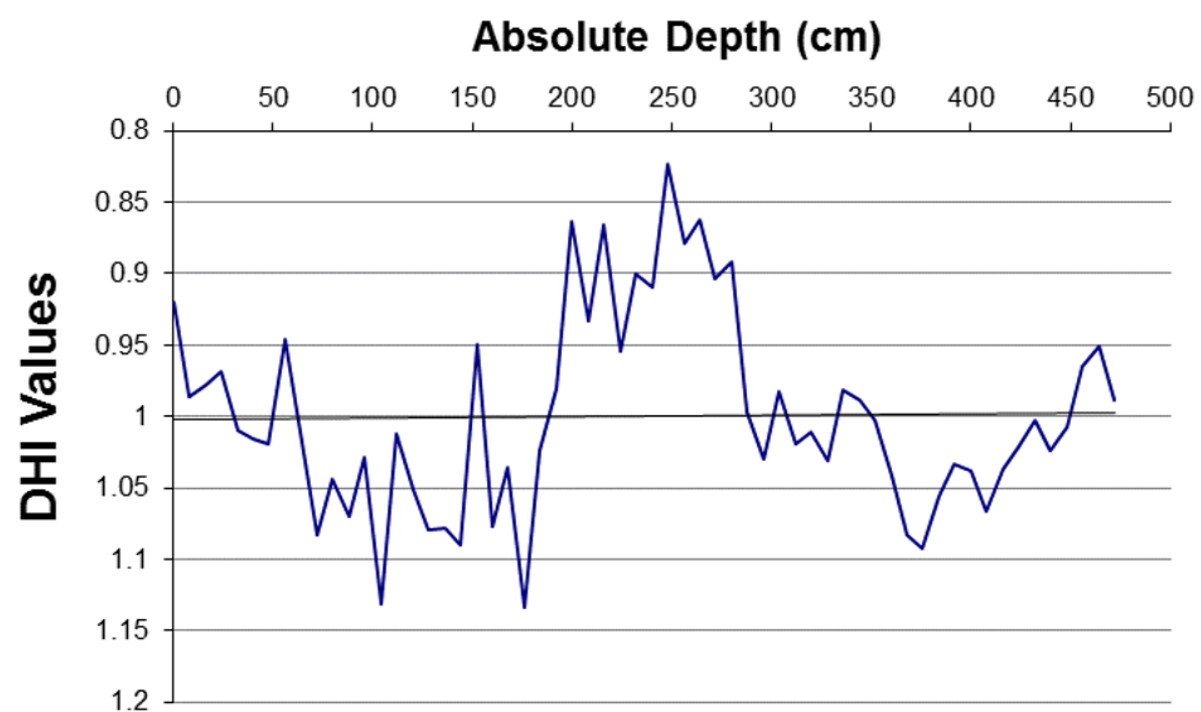
Figure 6. Smoothed and de-trended DHI curve for plant macrofossils. Indices used were: UOM 8, Ericales rootlets 8, Vaccinium oxycoccus 5, Calluna vulgaris 8, Ericaceae undifferentiated 8, monocots undifferentiated 6, Eriophorum vaginatum 6, Eriophorum angustifolium 2, Trichophorum cespitosum 6, Scheuchzeria palustris 2, Sphagnum imbricatum 4, Sphagnum papillosum 4, Sphagnum magellanicum 3, Sphagnum section Acutifolia 5, Sphagnum cuspidatum 1; based upon weights used in Daley & Barber (2012) and Mauquoy et al. (2008) together with knowledge of ecological tolerances and habitat preferences of each